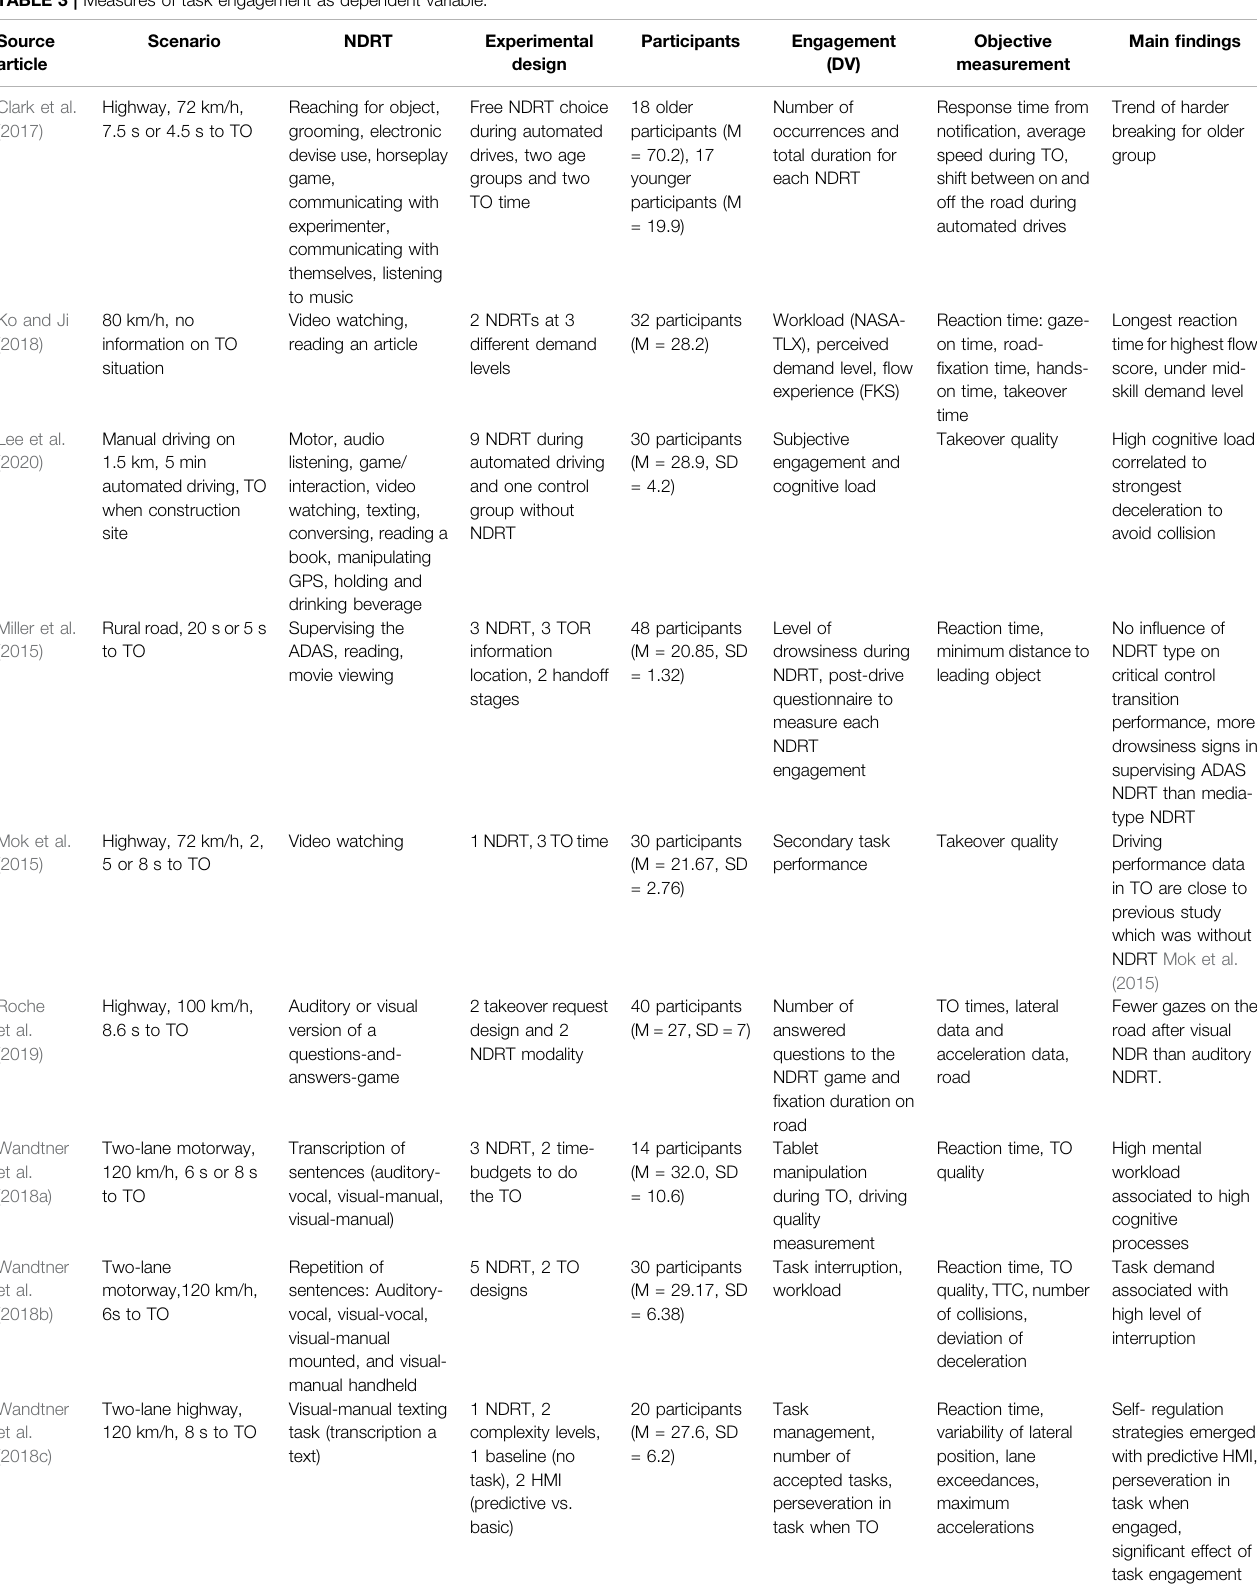
TABLE 3 | Measures of task engagement as dependent